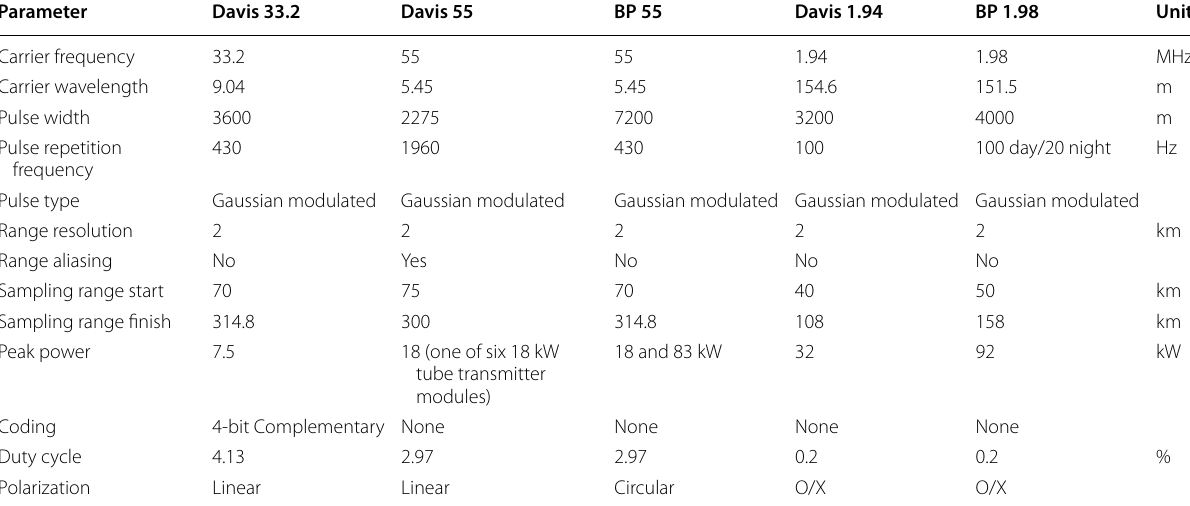
Table 1 Typical radar parameter sets used on the Davis and BP meteor and MF PR radars for the work described here